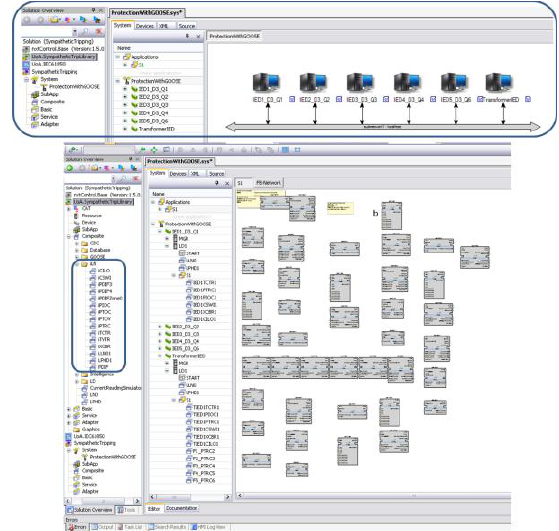
Figure 9. The generated IEC 61499 system with logical nodes as function